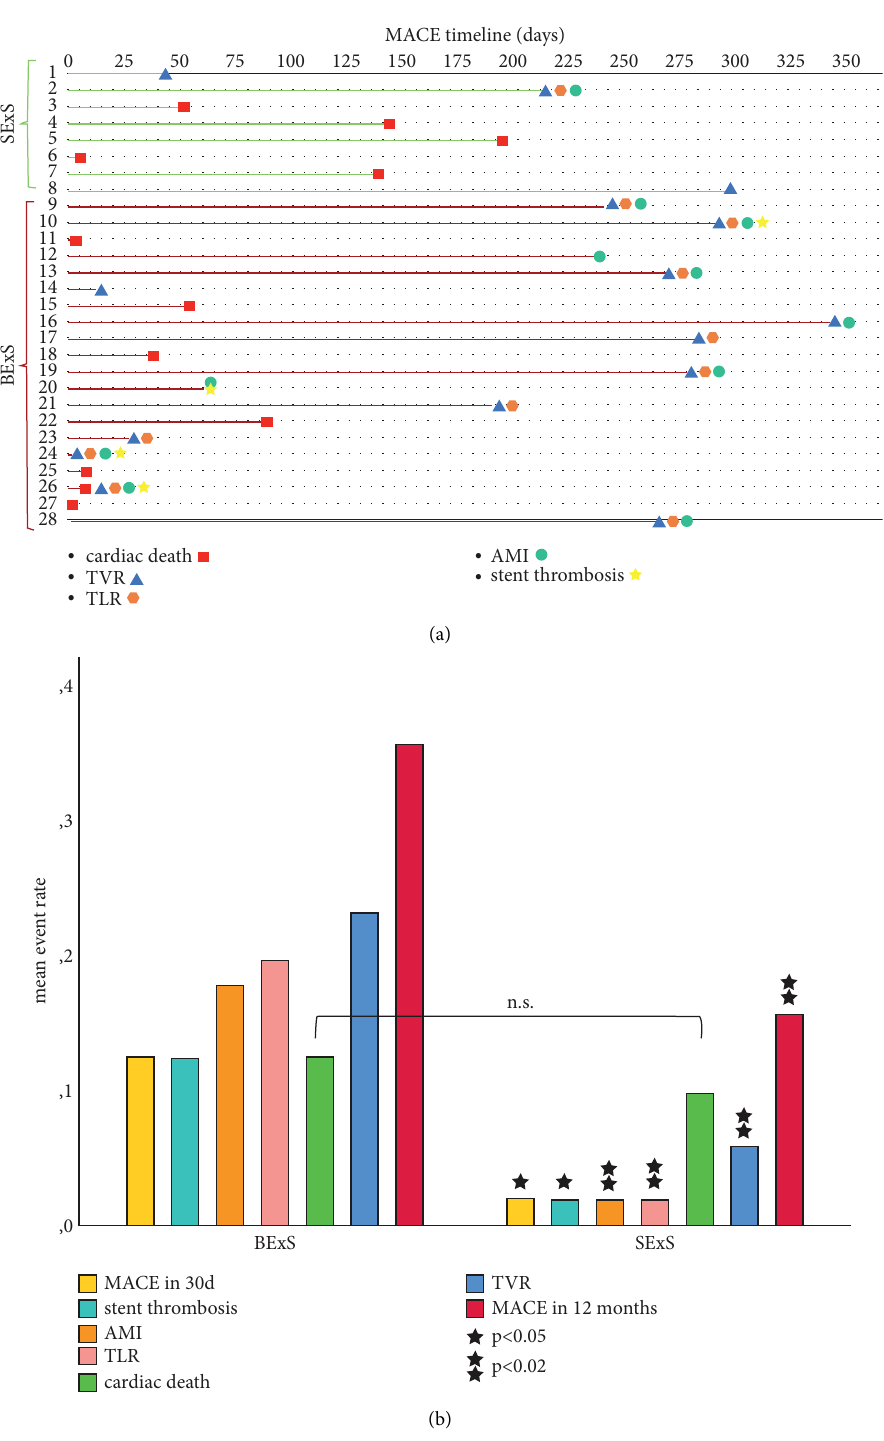
Figure 4: (a) MACE timeline of SExS and BExS patient groups. MACE � major adverse cardiac event; SExS � self-expanding drug eluting stent; BExS � balloon expanding drug eluting stent; TVR � target vessel revascularization; TLR � target lesion revascularization; AMI � acute myocardial infarction. (b) Mean event rates in BExS patient group compared to SExS group. SExS � self-expanding drug eluting stent; BExS � balloon expanding drug eluting stent; MACE � major adverse cardiac event; AMI � acute myocardial infarction; TLR � target lesion revascularization; TVR � target vessel